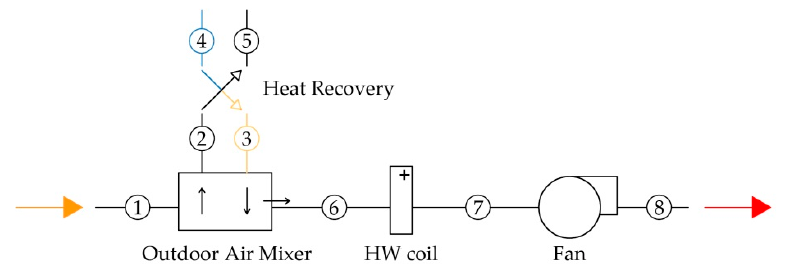
Figure 6. Air loop on supply side.